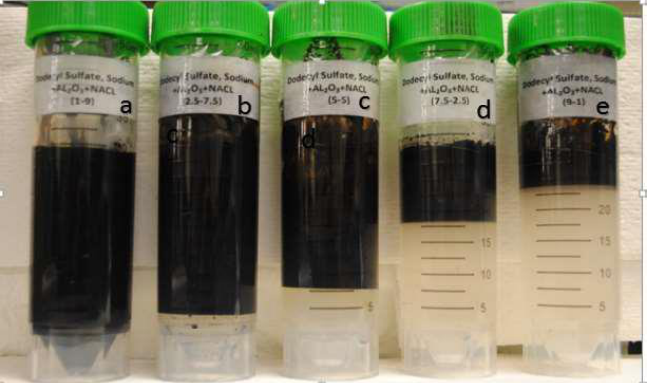
Figure 6—SDS with Al